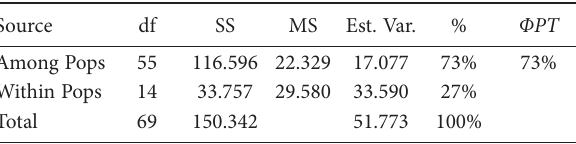
Table 4. Analysis of molecular variance (AMOVA) of the studied species.